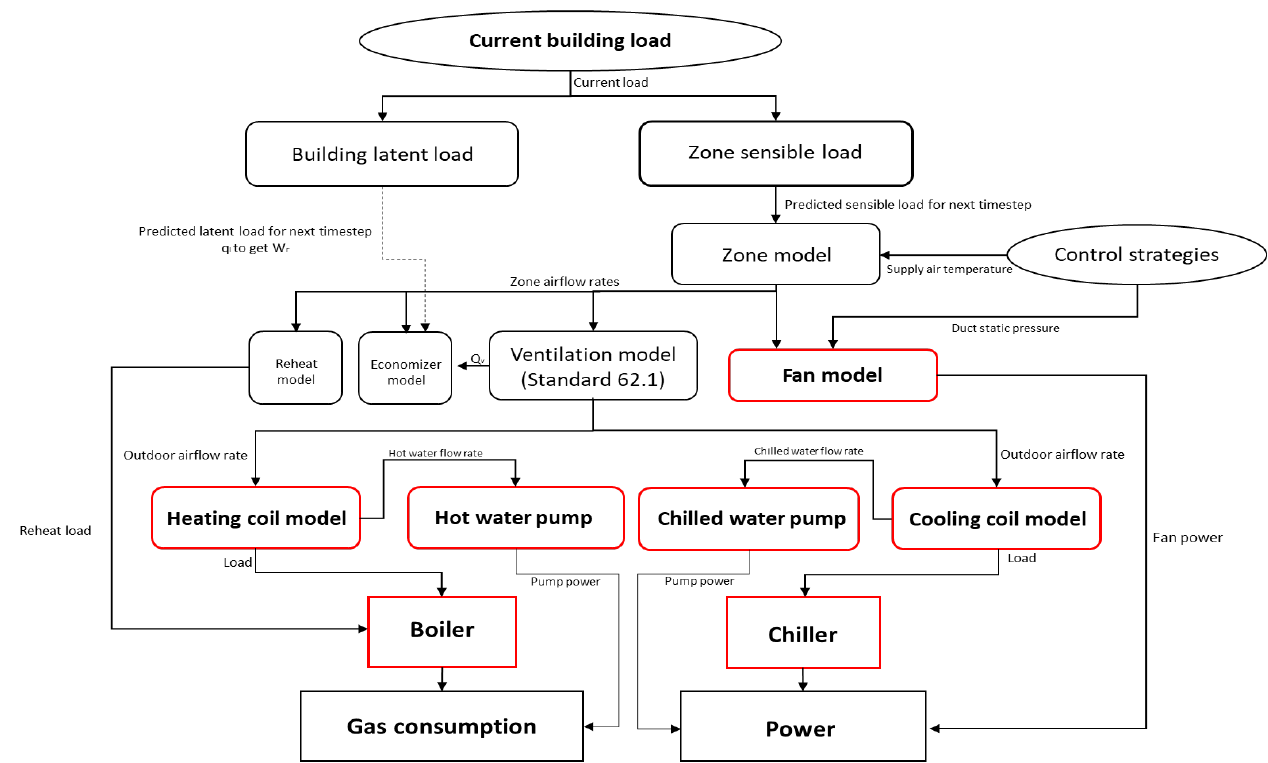
Figure 2. A schematic of the integrated optimization process.